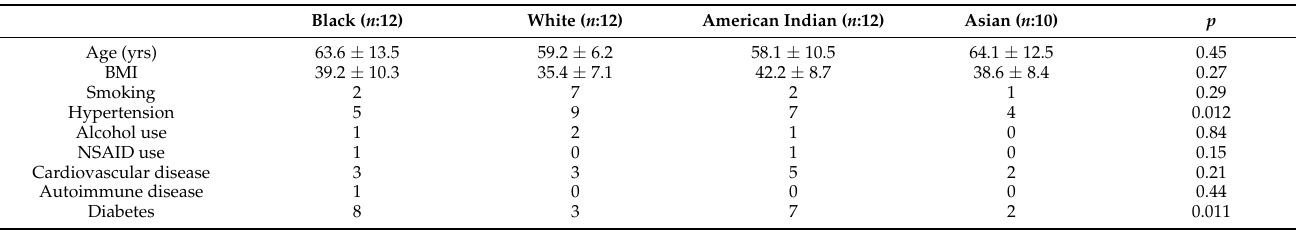
Table 1. Comparison of patient characteristics between groups. Black ( n